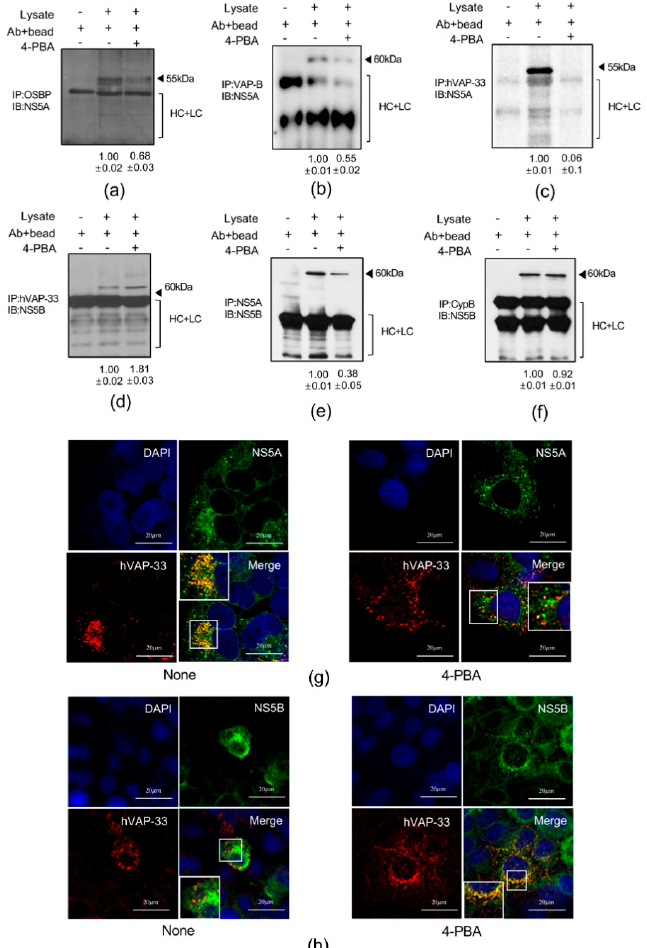
Figure 8. 4-PBA inhibited replication complex interactions. ( a – c ) Immunoprecipitation was performed with Huh7.5-Con1 cells with or without 1 mM 4-PBA treatment for 24 h using antibodies against OSBP ( a ), VAP-B ( b ), or hVAP-33 ( c ), and precipitated protein complexes were probed with anti-NA5A antibodies. ( d – f ) Immunoprecipitation was performed with Huh7.5-Con1 cells treated with or without 1 mM 4-PBA for 24 h using antibodies against hVAP-33 ( d ), NS5A ( e ), or CypB ( f ), and precipitated protein complexes were probed with anti-NS5B antibodies. The arrowheads indicate antibodies used for immunoprecipitation. HC, antibody heavy chain; LC, antibody light chain. ( g , h ) Indirect immunofluorescence analysis of Huh7.5-Con1 cells with or without 1 mM 4-PBA treatment for 24 h using antibodies against NS5A (green) and hVAP-33 (red) ( g ) or NS5B (green) and hVAP-33 (red) ( h ). DAPI (blue) was used to visualize nuclei. Merged images of green and red signals are shown in panels. Scale bar = 20 µ